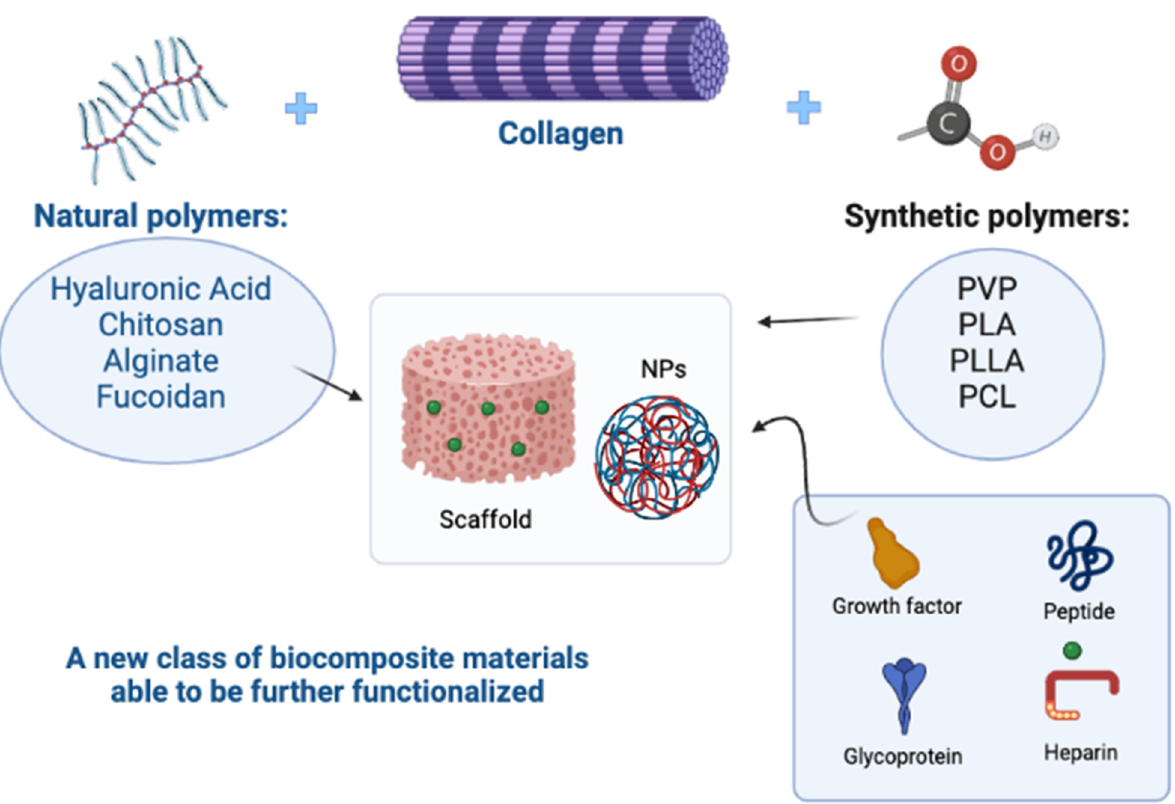
Figure 5. The use of synthetic and natural polymers in blends has led to the development of a new class of materials that support the poor mechanical properties of natural polymers, improving their important biological functions. In addition, scaffolds and nanoparticles (NPs) can be further func- tionalized with glycosaminoglycans such as heparin, glycoproteins, peptides, or growth factors, to improve the biocompatibility of the devices (Polyvinylpyrrolidone-PVP; Polylactic acid-PLA/PLLA; Polycaprolactone-PCL). Created with BioRender.com.